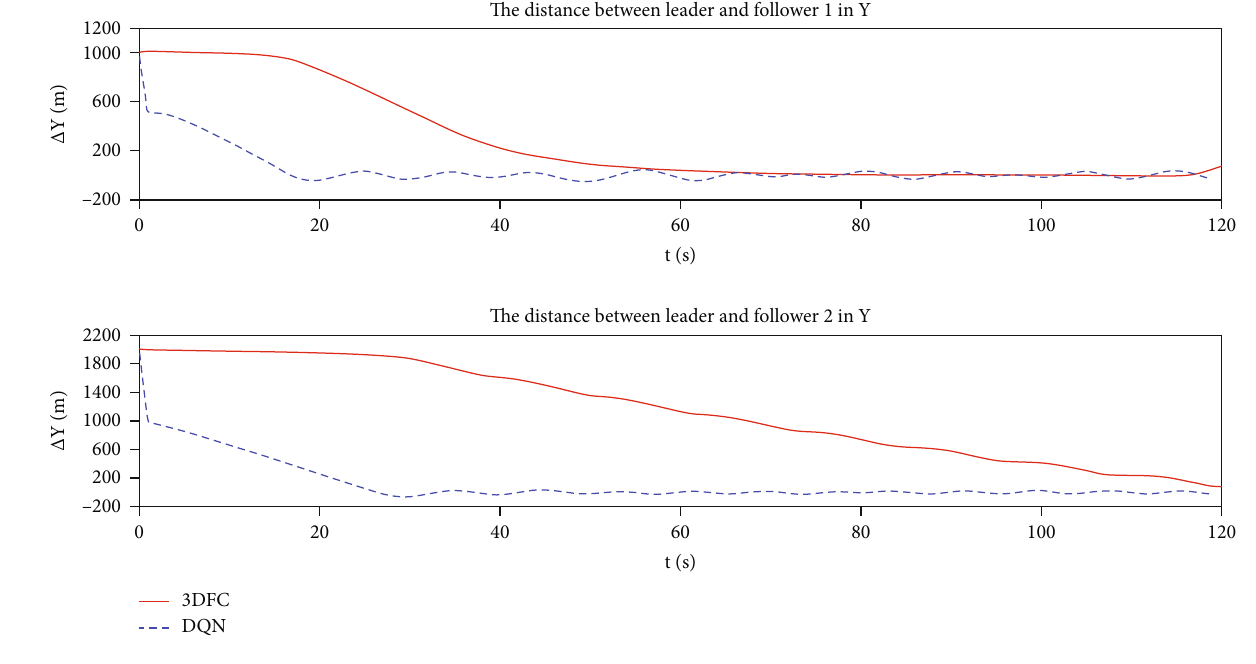
Figure 8: The relative distance Δ Y between the leader and the followers.